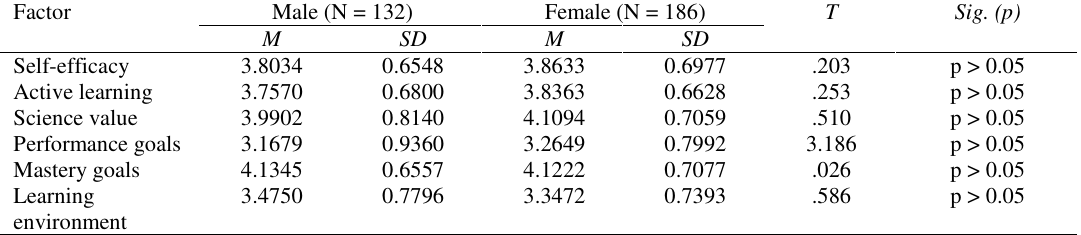
Table 1 Means, standard deviations and significance of differences between the boys and girls on six motivation factors